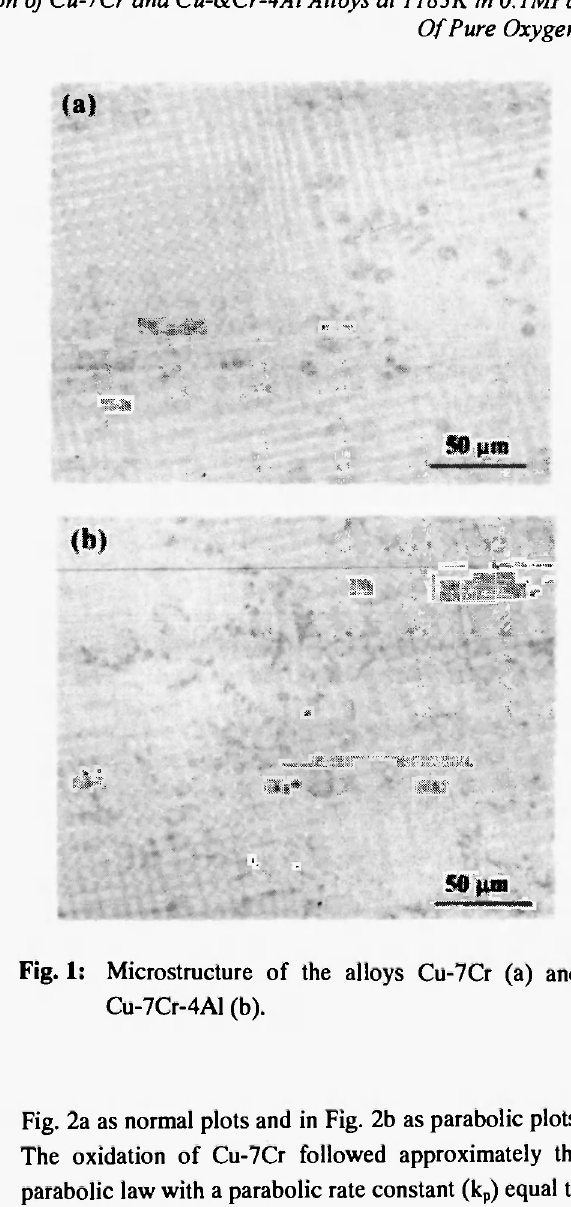
Fig. 2a as normal plots and in Fig. 2b as parabolic